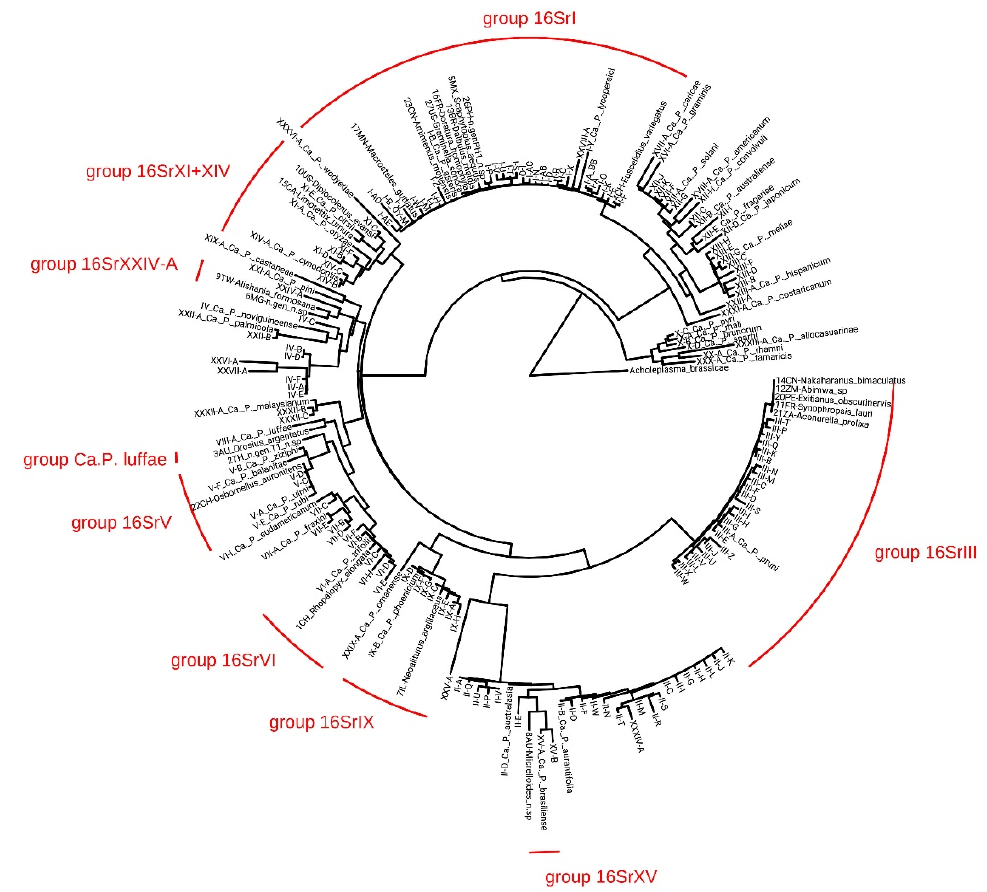
Figure 4. Maximum-likelihood tree of the 16S rRNA gene for 169 phytoplasma strains from Gen- Bank, 23 phytoplasma 16Sr sequences ( ≥ 1243 bp) newly predicted by the HybPiper method and Acholeplasma brassicae (FO681348.1) (outgroup). Clades containing the 23 samples from this study are indicated in red.